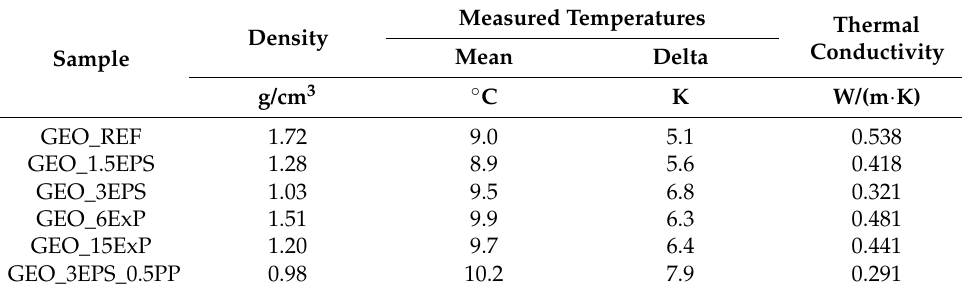
Table 5. Thermal conductivity values of selected geopolymer samples.